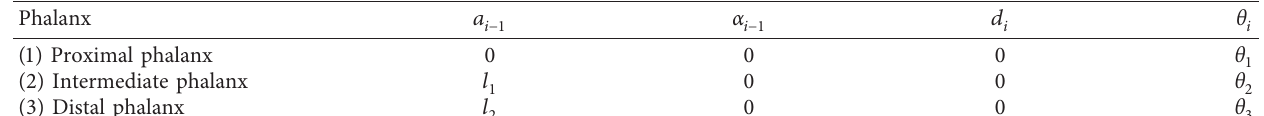
Table 7: D–H parameters.